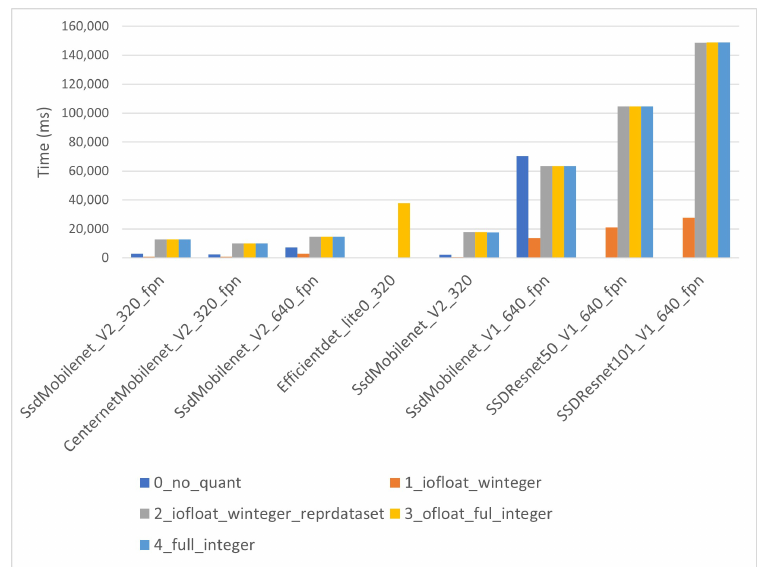
Figure 13. i-MX8M-PLUS warm up